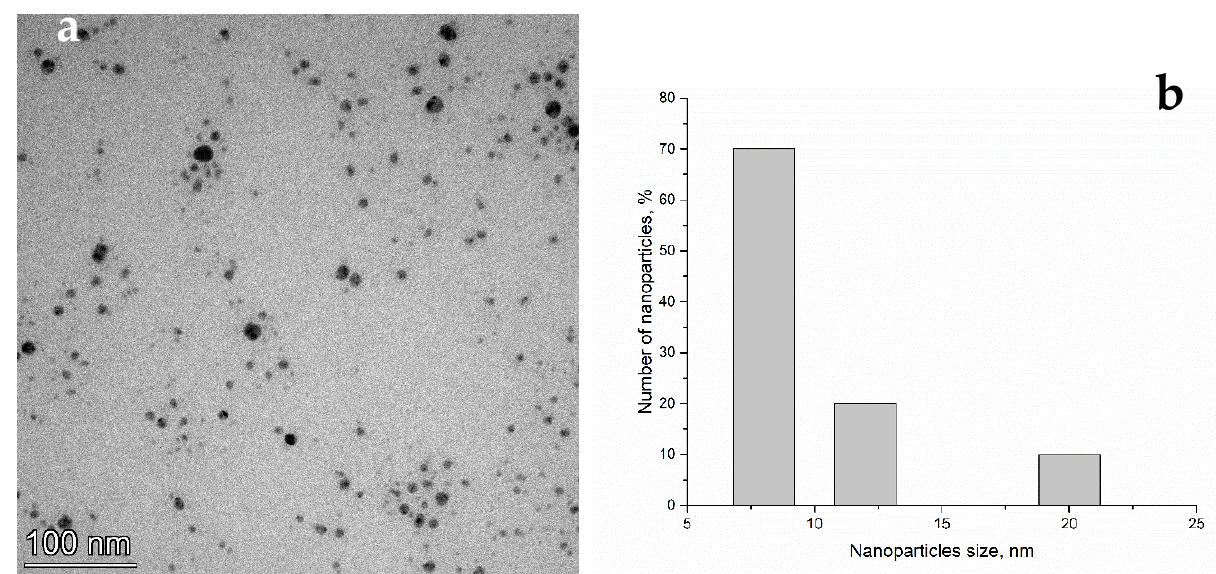
Figure 1. TEM image ( a ) and size histogram ( b ) of AgNPs nanoparticles.